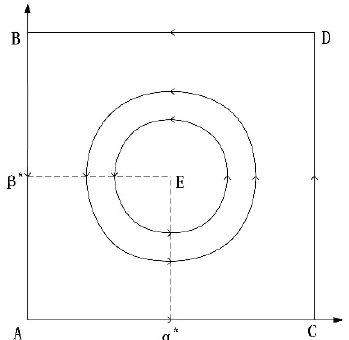
Table 4. Local stability analysis of scenario 2 between local government and coal-related enter- prises.